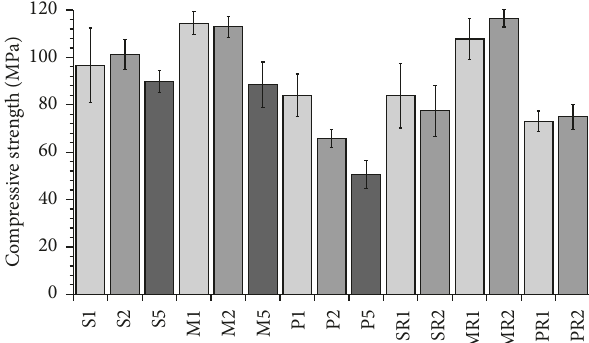
Figure 1: Compressive strength of prepared matrices (28